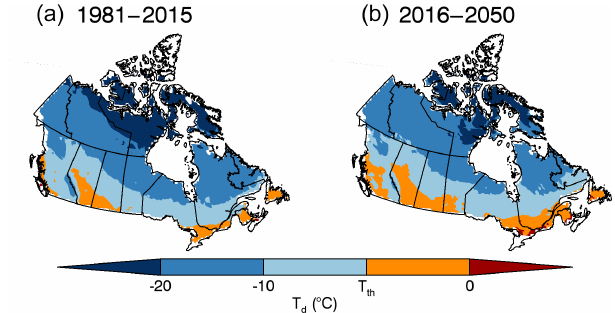
Figure 12. Temperature and precipitation controls on March snow water equivalent for historical period (a) and projections to 2050 (b) . For the data presented here T th = − 5.4 ◦ C (more gen- erally T th = − 5 ± 1 ◦ C). Regions with T d <T th (blue) have March SWE dominated by precipitation variability while regions with T d >T th (orange) have March SWE dominated by temperature vari-